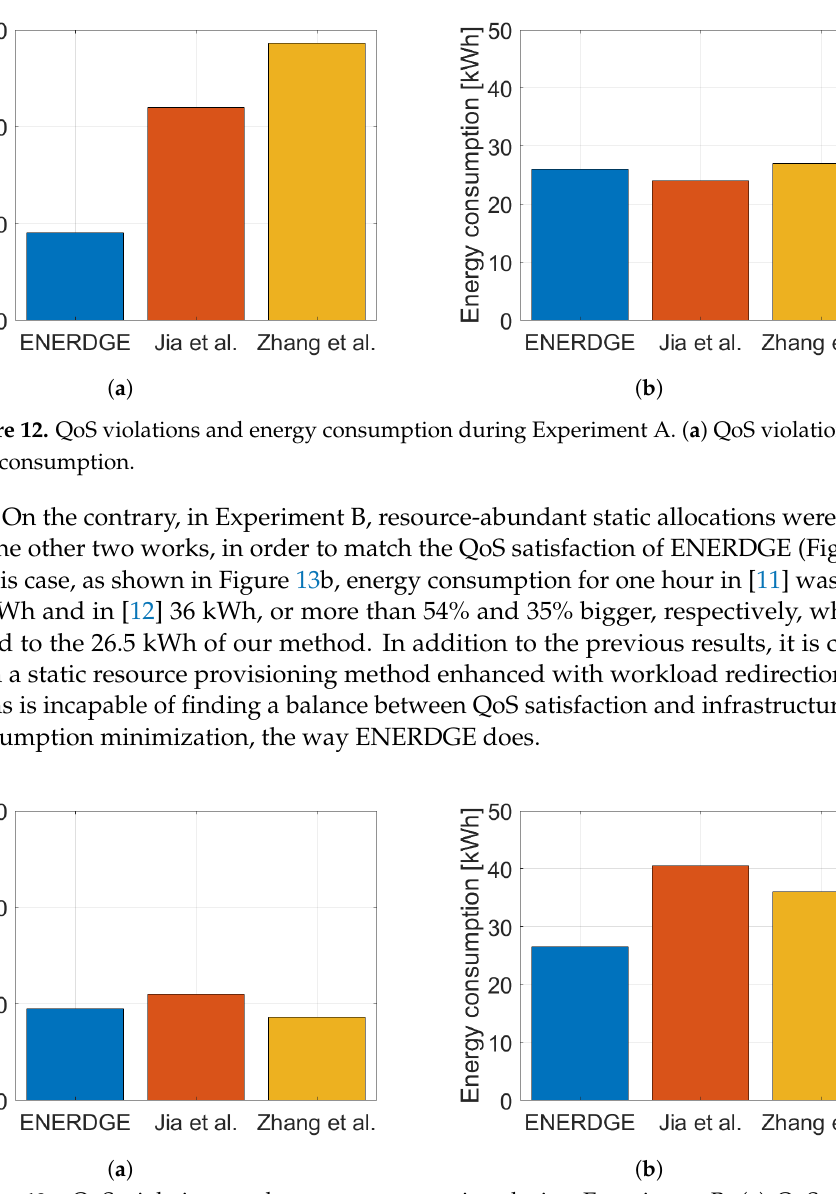
Figure 13. QoS violations and energy consumption during Experiment B. ( a ) QoS violations; ( b ) energy